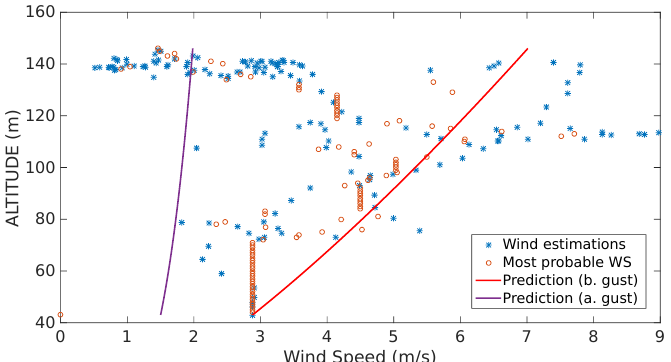
Figure 16. Estimation, most probable wind speeds and last wind prediction generated throughout the flight shown in Figure 14b.